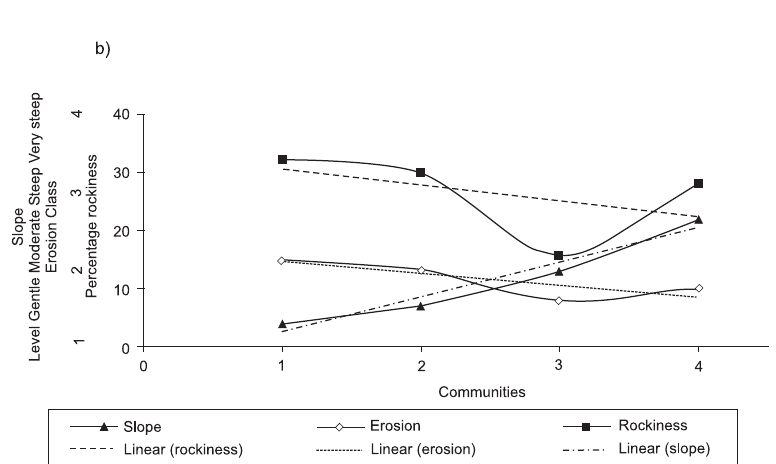
Fig. 4. Community ordination scatter diagrams depicting a) tree cover, shrub cover, herb cover, and grass cover with trend lines portraying tendencies in the aforementioned parameters from community 1 through community 4; and b) slope, erosion and rockiness with trend lines depict- ing inclinations of aforementioned parameters from community 1 through community